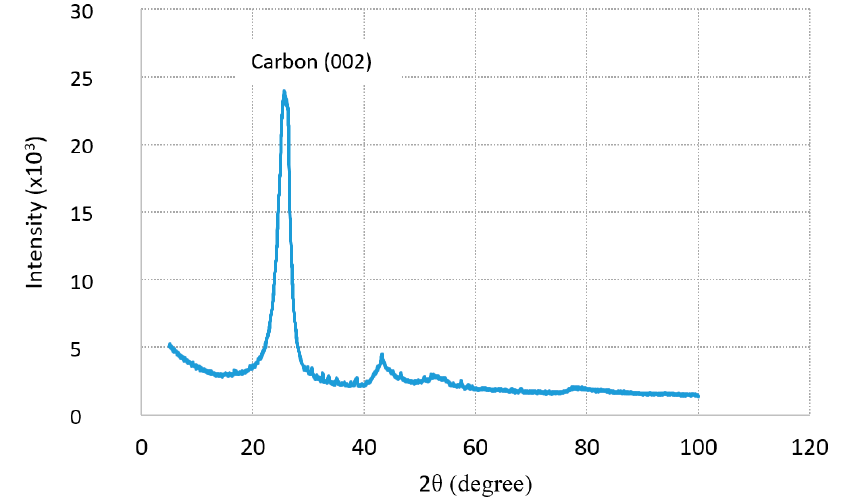
Figure 4. XRD pattern of carbon dust.